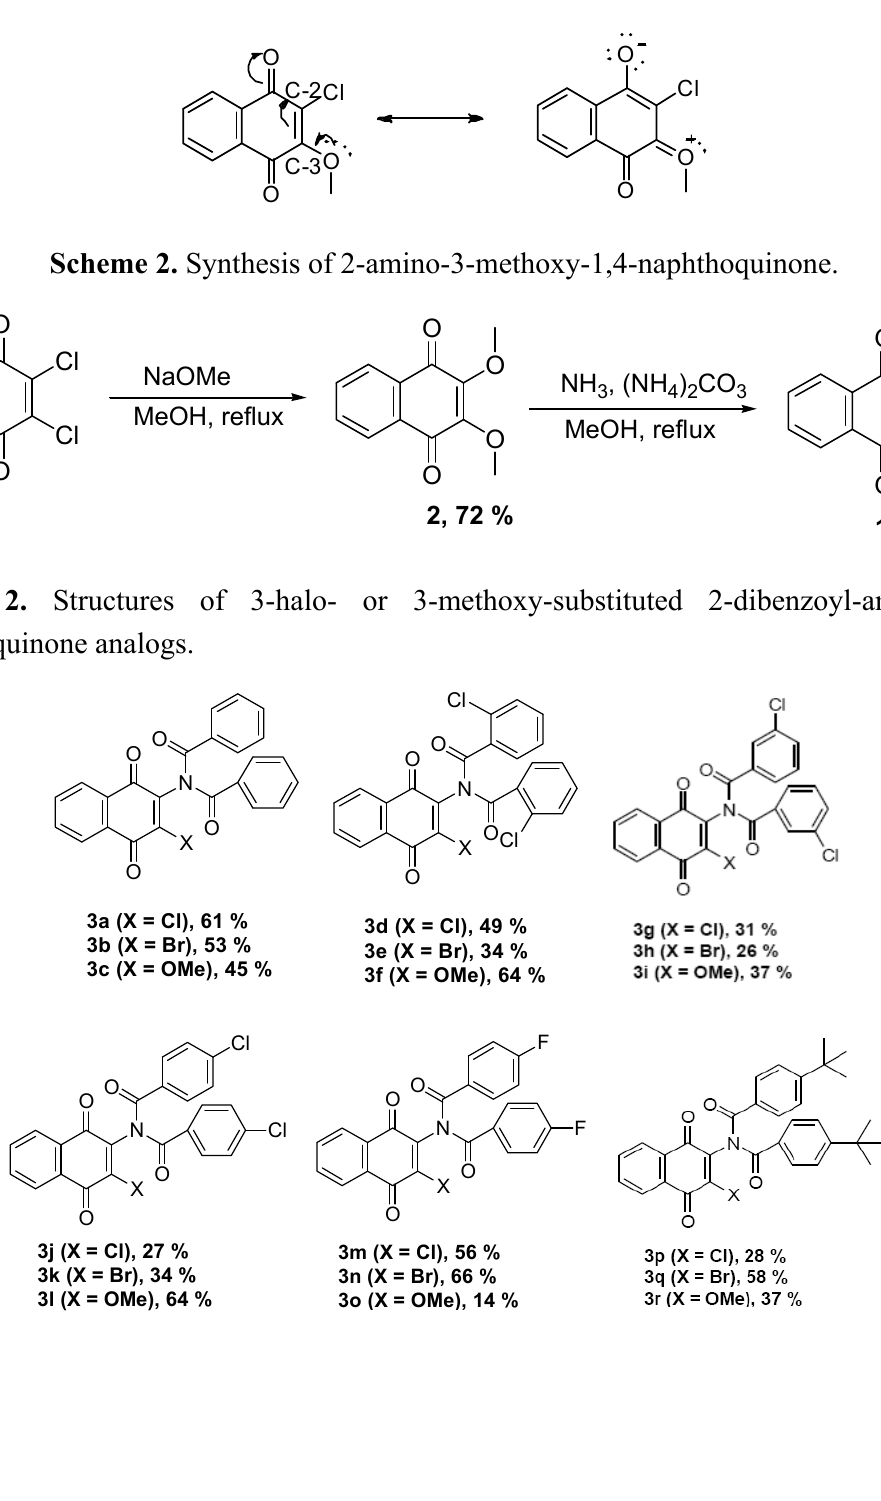
Figure 1. Delocalization of electrons from the methoxy group on C-3 reduces the electrophilicity of C2.